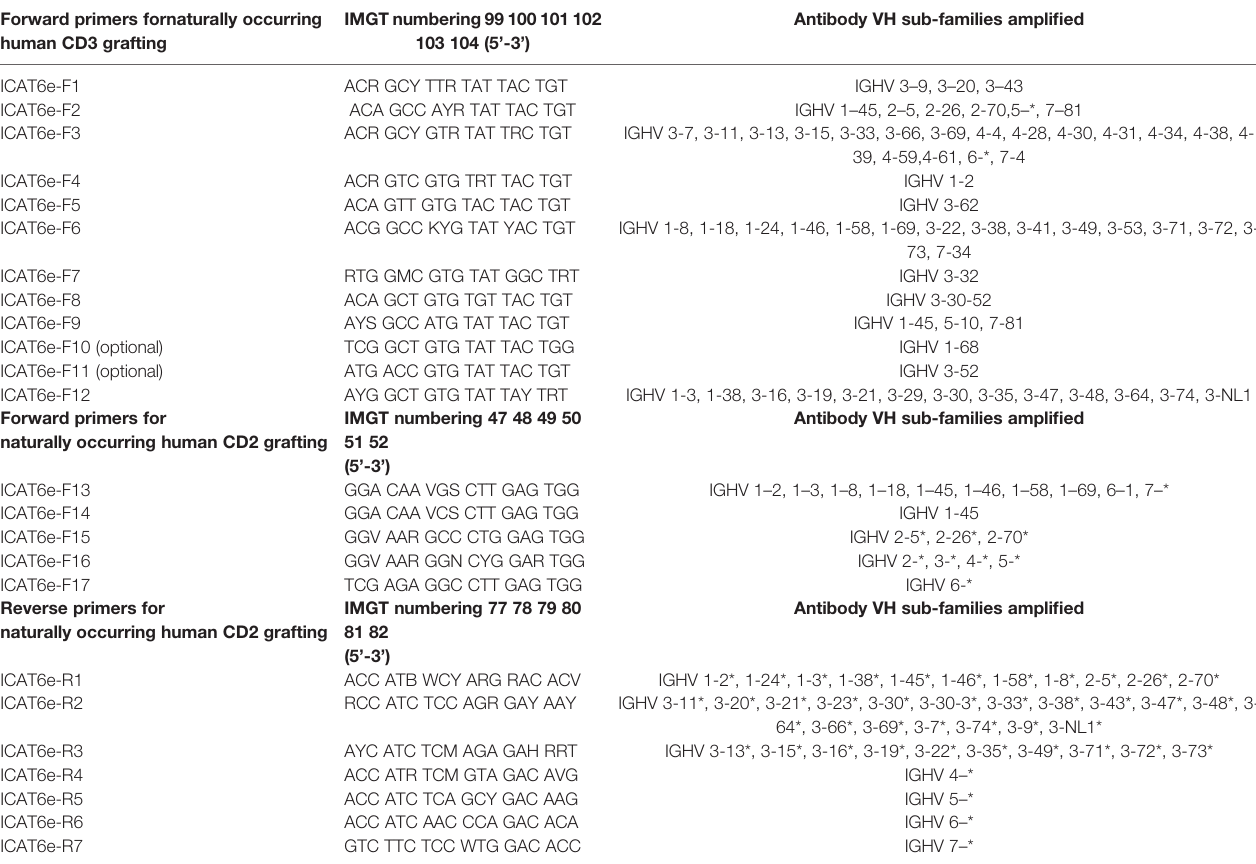
TABLE 2 | Primers for CDR2 and CDR3 gene